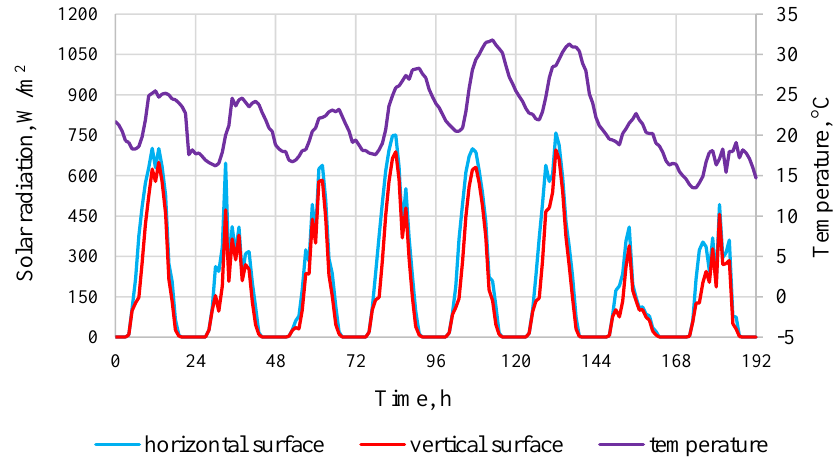
Fig. 3. Outdoor air temperature and solar